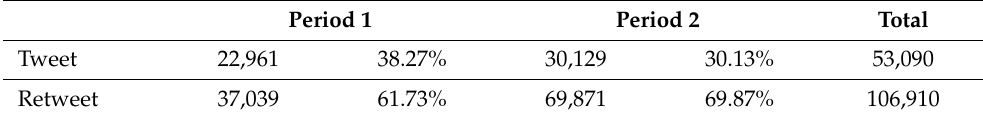
Table 1. Number of tweets and retweets.